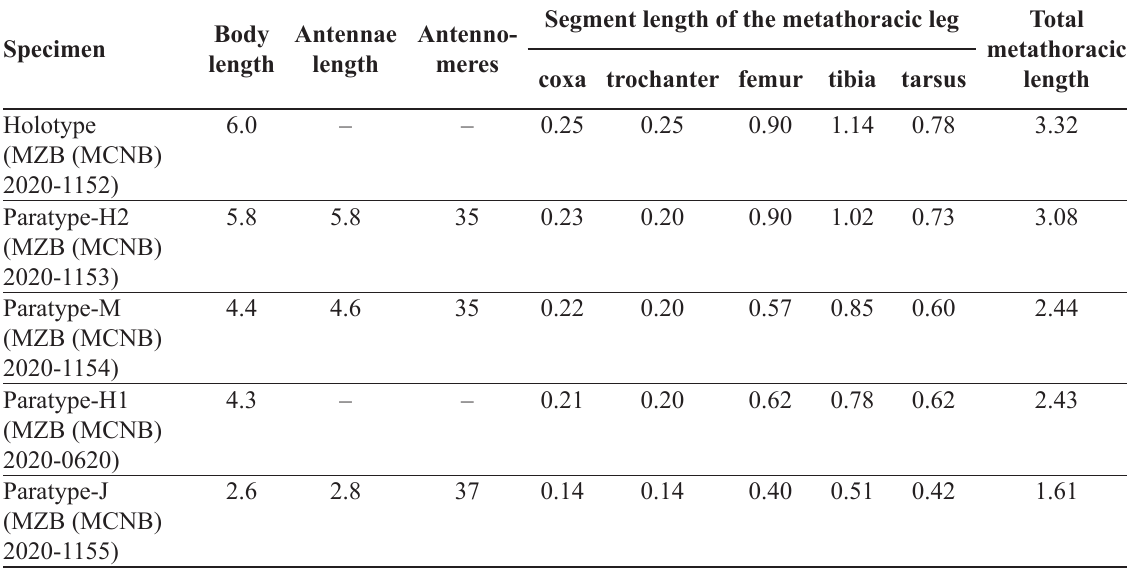
Table 1. Anisuracampa ywangana Sendra & Komerički sp. nov., length of the body, antennae and metathoracic leg, including their segments, and cerci (units in mm) as well as number of